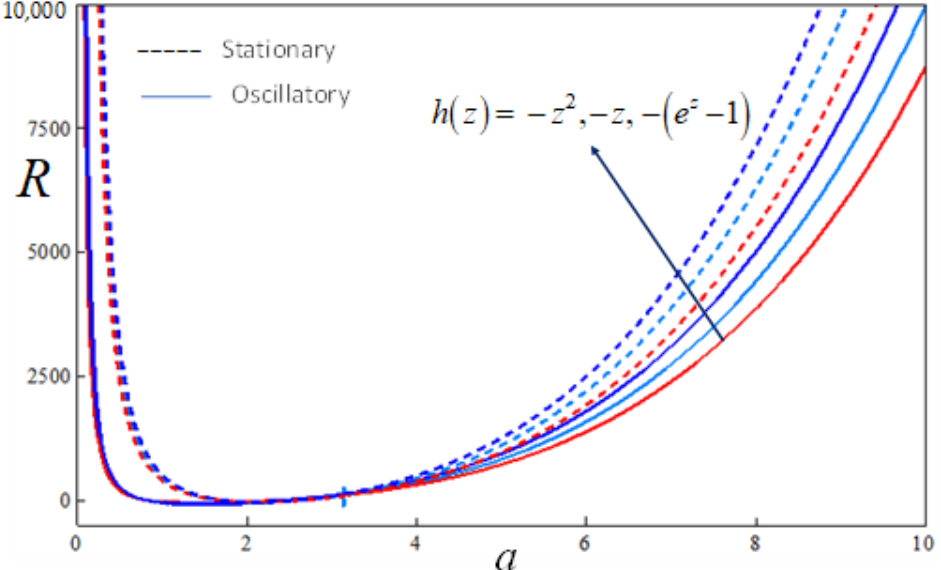
Figure 8. Plot of R verses a for different cases of gravity variation when Le = 0.5, Rs = 10, Da = 0.1, ξ = 0.5, η = 0.5 and δ = 0.5.